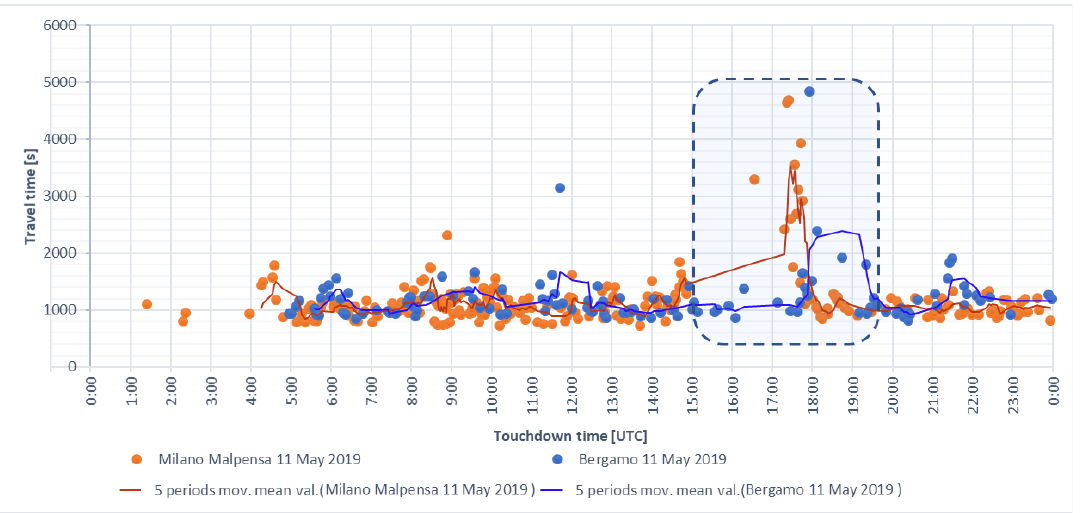
Figure 13. Visualization of travel time in the extended TMA and touchdown time for historical traffic at MXP (orange color) and at BGY (blue color) on 11 May 2019.